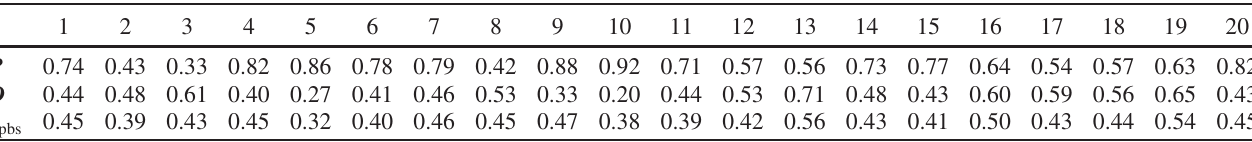
) for each item of the TUV. pbs